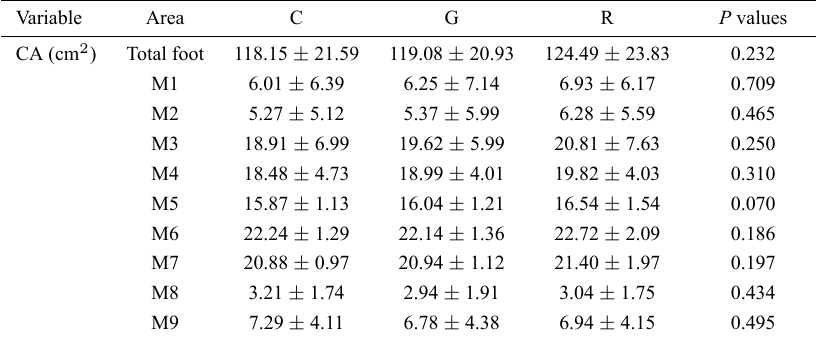
Table 3. Comparison of CA for running on different